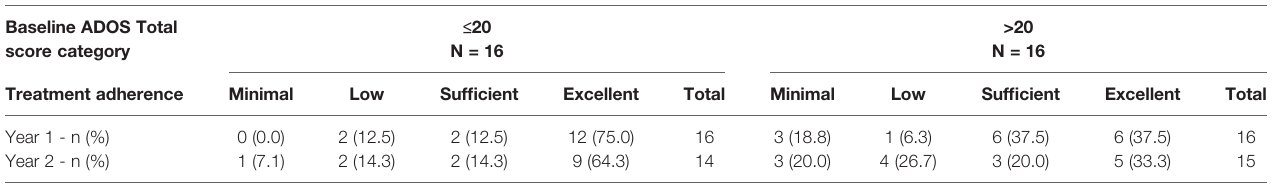
TABLE 6 | Correlations between treatment adherence, ADOS scores, and DD-C-GAS fi ndings at both Year 1 and Year 2. Spearman-rho ADOS Year 1 Treatment adherence Corr. Coeff.